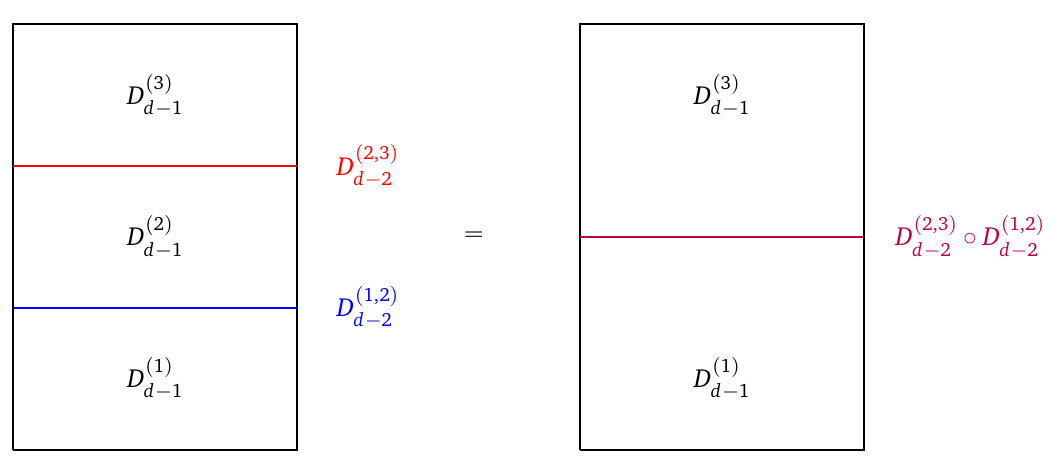
and D p 2,3 q leads to the defect d ´ 2 d ´ 2